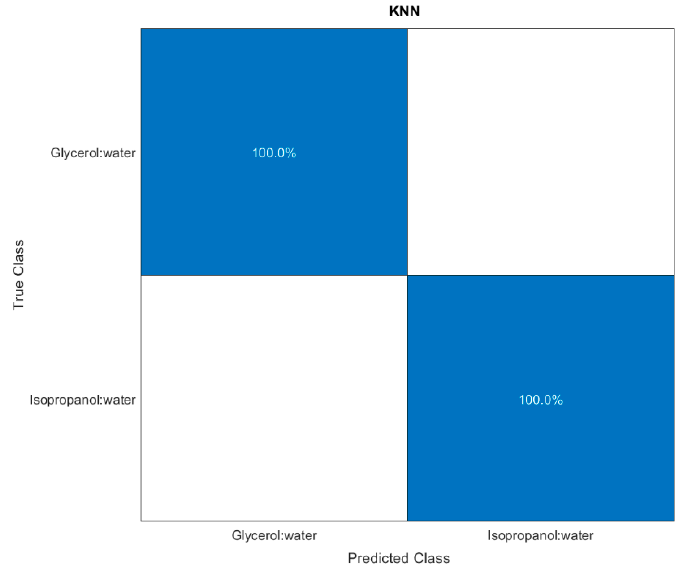
Figure 8. Confusion matrices obtained for the predictions over a stratified cross-validation proce- dure.